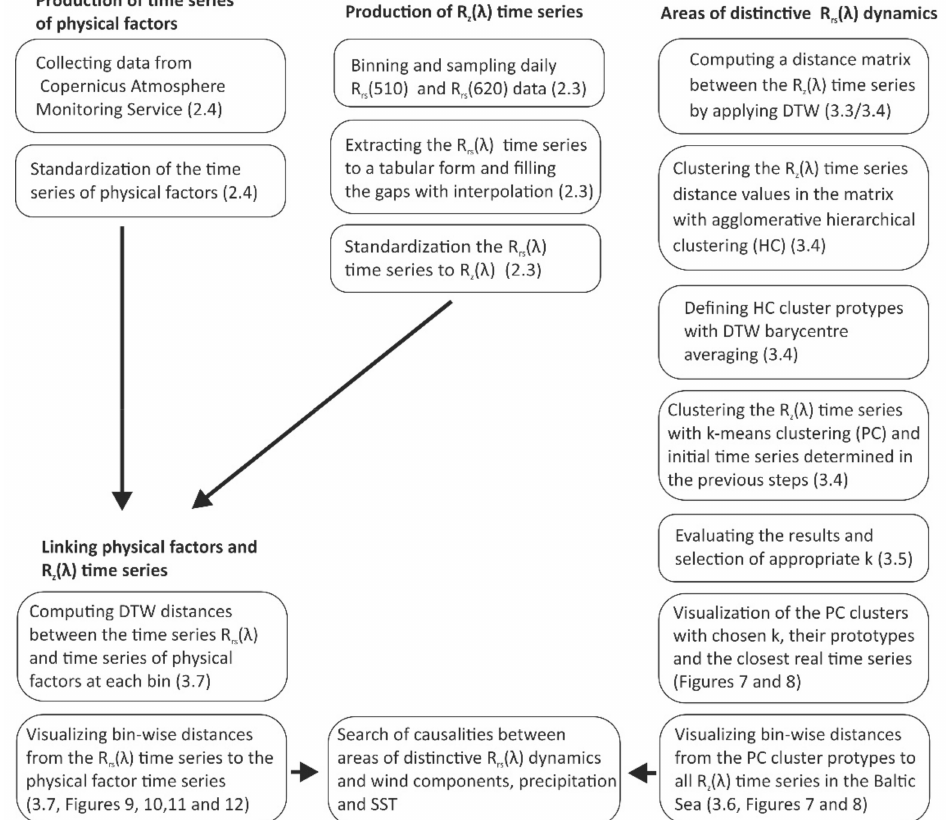
Figure 4. Summary of the workflow presented in the Sections 2 and